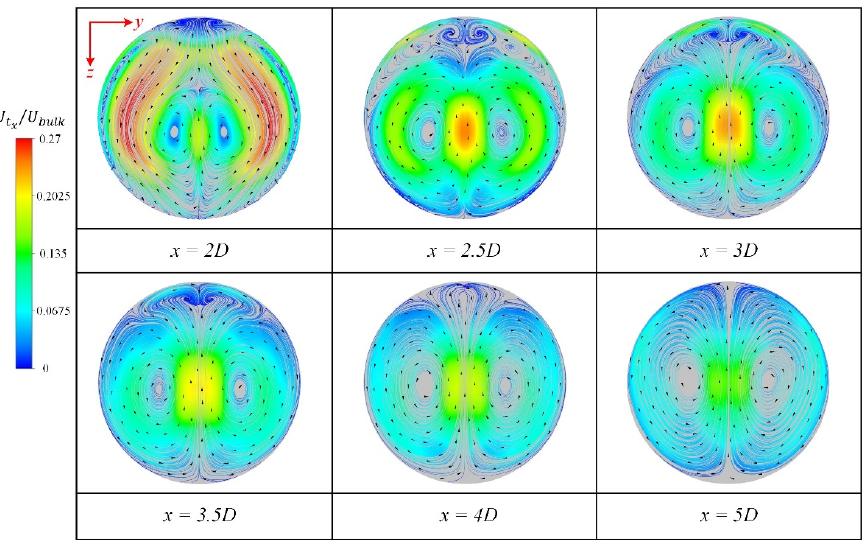
Figure 7. Streamlines and tangential velocity vectors downstream the second bend in Case-0°-3D .